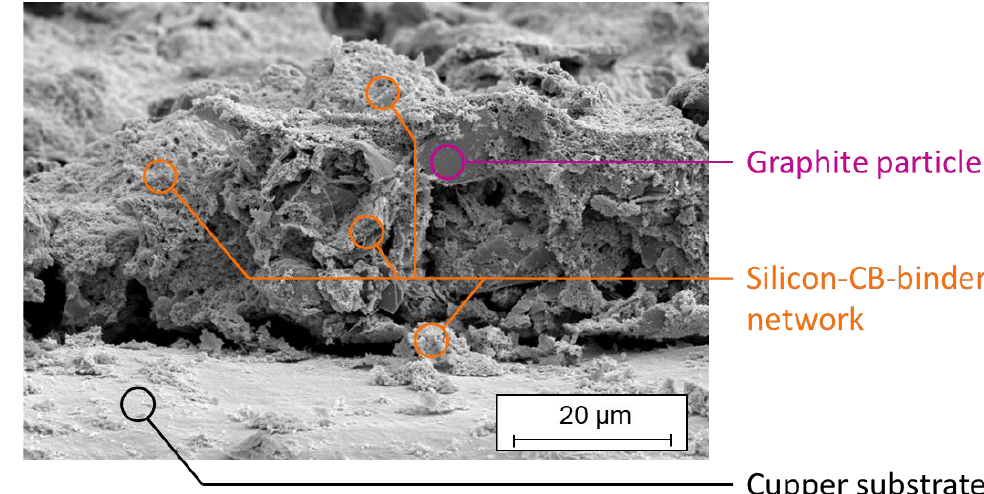
Figure A2. Cross-section of an exemplary silicon-rich anode (area capacity: 2 mAh·cm −2 ).